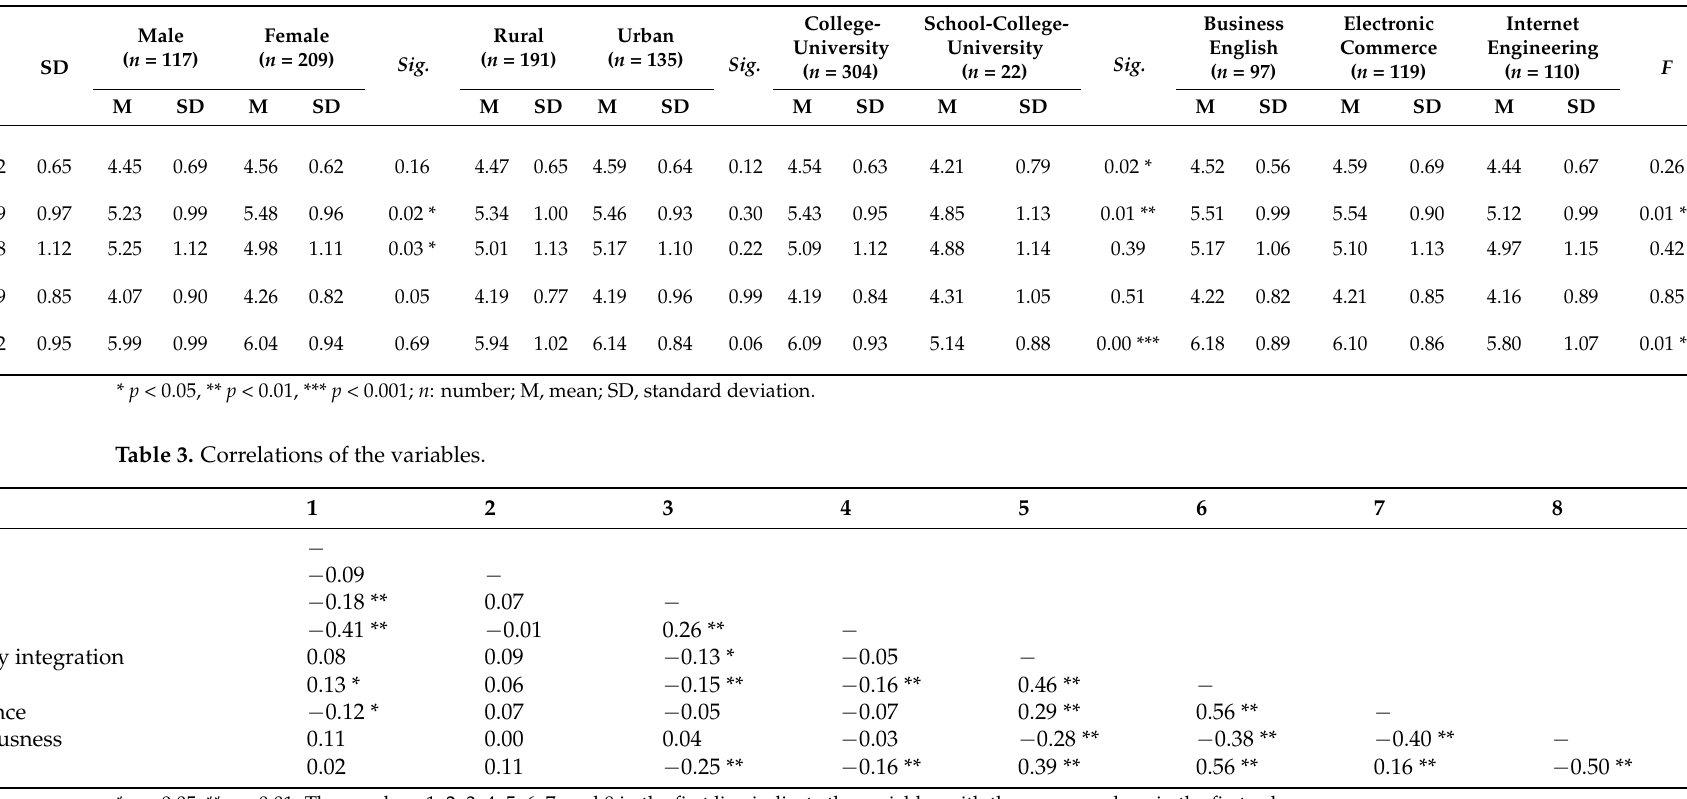
Table 2. Means, standard deviations, and significant differences among variables in gender, residency, upgrade, and disciplines.